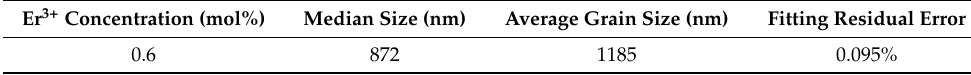
Table 3. Information of DLS test for the sample (Er 3+ : 0.6 mol%).